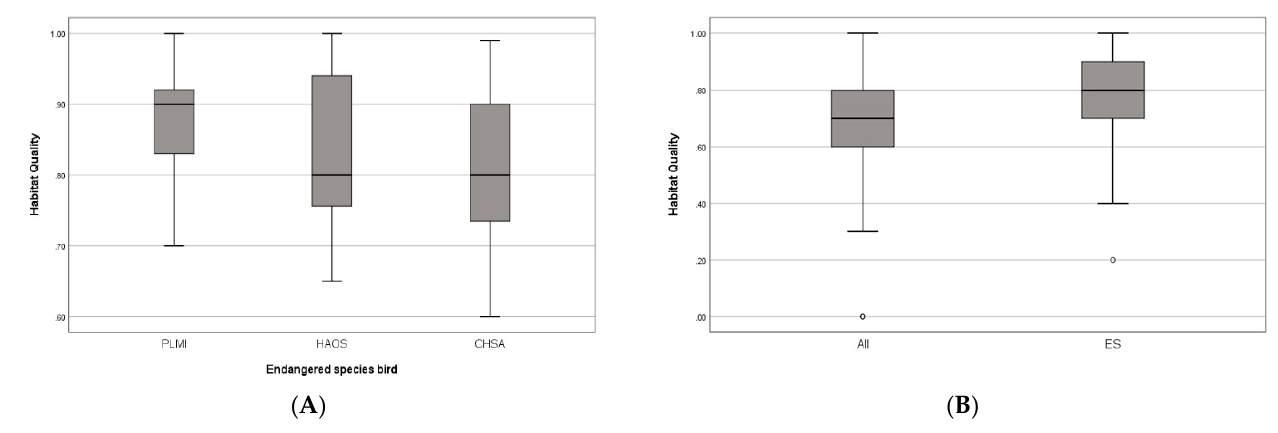
Figure 7. Habitat quality. ( A ): All bird points (n = 261), ( B ): Endangered bird species. PLMI: Platalea minor (n = 12); HAOS: Haematopus ostralegus (n = 35); CHSA: Chroicocephalus saundersi (n = 27). p < 0.05. Box: 25–75%; line: median; whiskers; minimum and maximum values; circles: individual outliers. Table 8. Correlation coefficient between the ecological natural map and habitat quality.